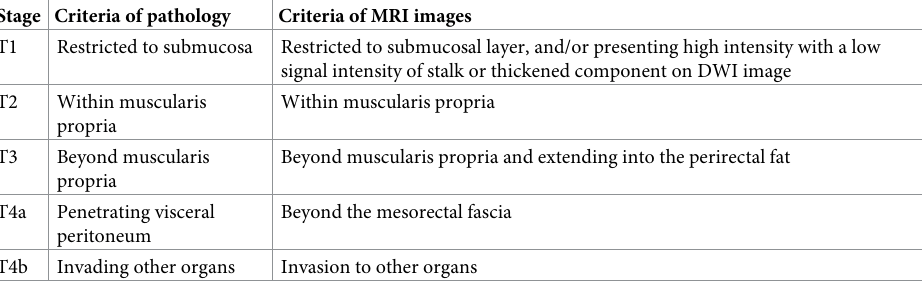
Table 2. Criteria of pathology and MRI images for T-staging of rectal